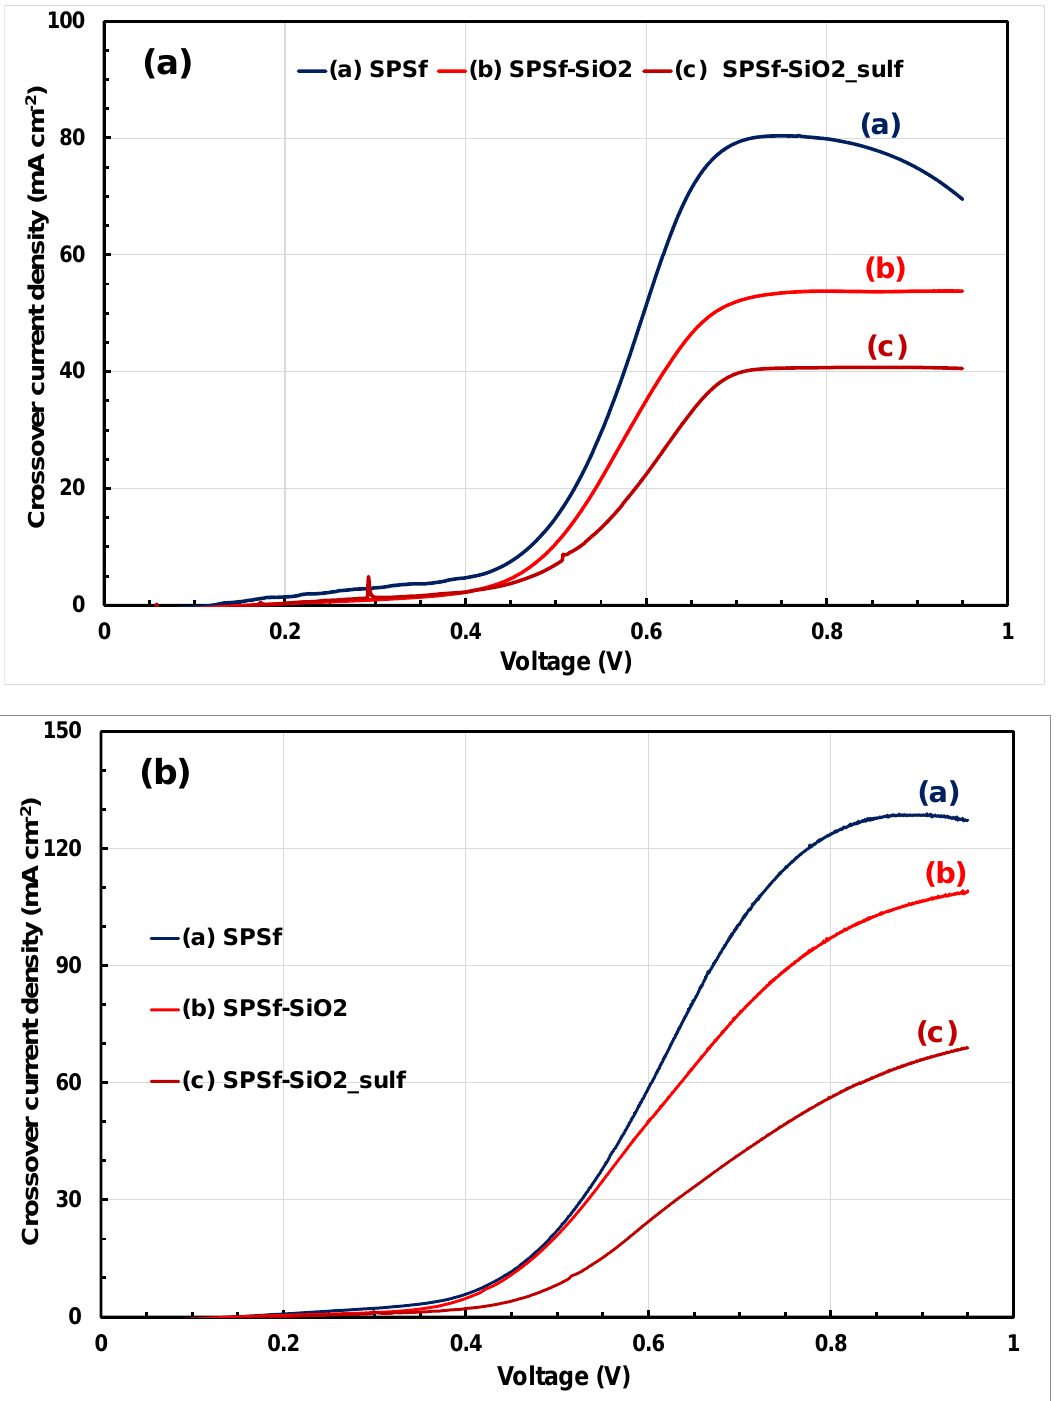
Figure 5. Comparison of methanol crossover current densities, using a 5 M methanol solution, for the SPSf and composite SPSf membranes at ( a ) 30 °C and ( b ) 60 °C.